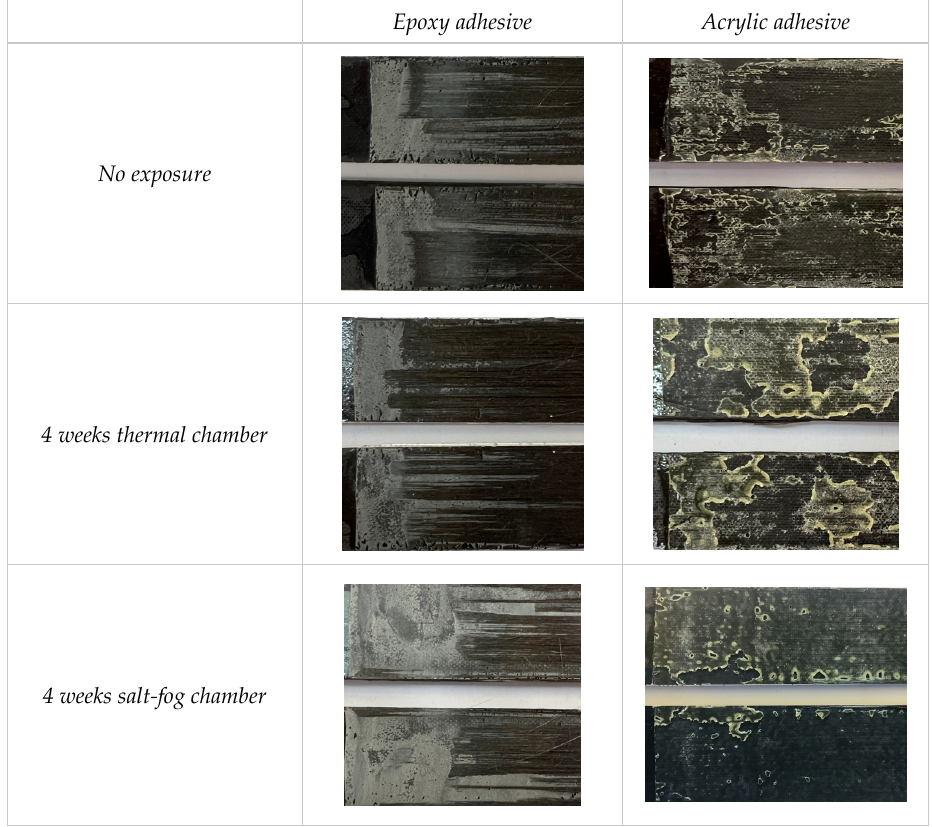
Figure 13. Fracture surfaces of both adhesives studied for each type of aging and different exposure periods.